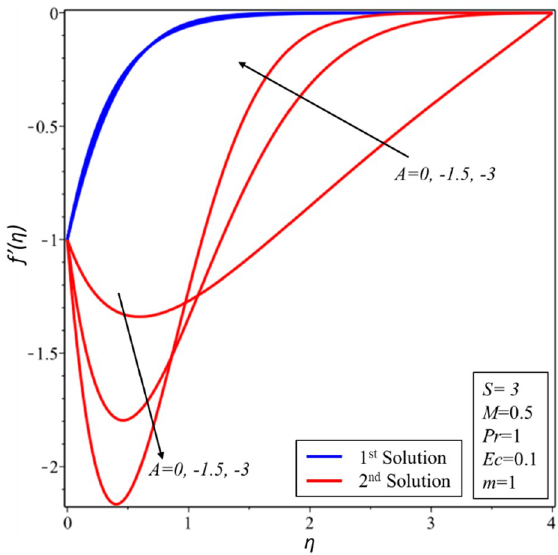
Figure 3. f (cid:48) ( η ) for increasing values of A and α = 1. Figure 3. ′(η) for increasing values of A and α = 1. Figure 3. ′(η) for increasing values of A and α = 1.